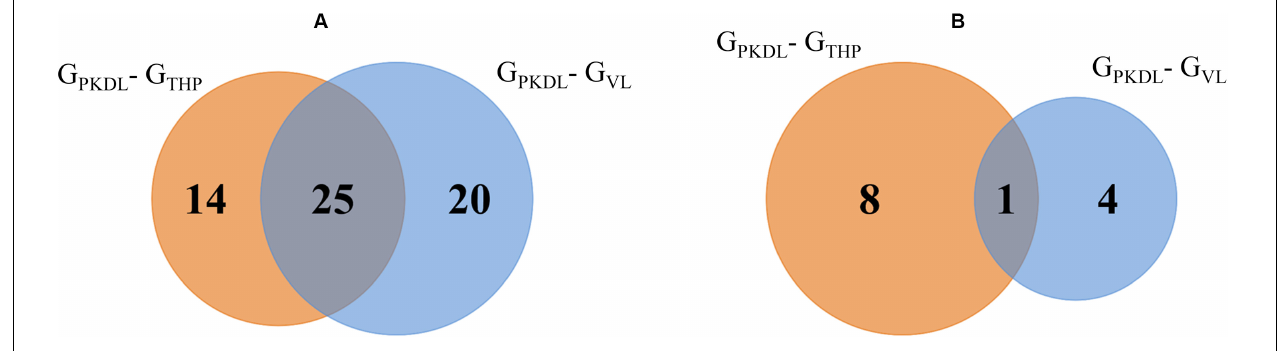
FIGURE 5 | Venn diagram shows the G PKDL upregulated microRNAs (miRNAs). (A) Overlaps of known upregulated miRNAs of G PKDL with respect to G THP and to G VL . (B) Overlaps of novel upregulated miRNAs of G PKDL with respect to G THP and G VL